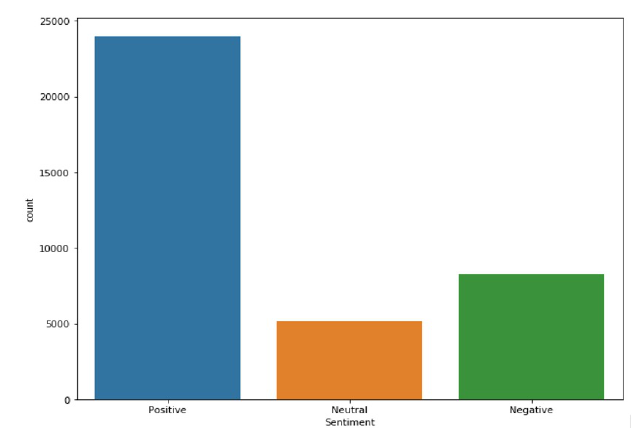
Figure 6. Number of tweets in positive, negative and neutral